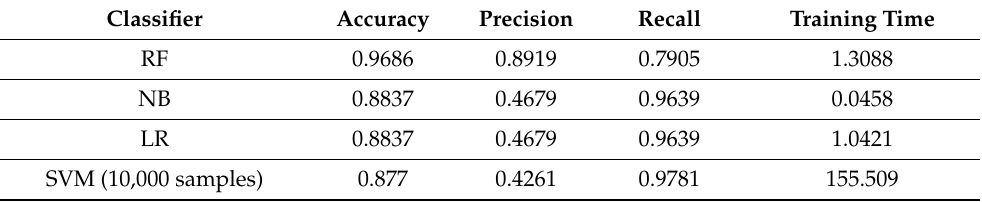
Table 7. Comparison of various machine learning models for combined dataset from two